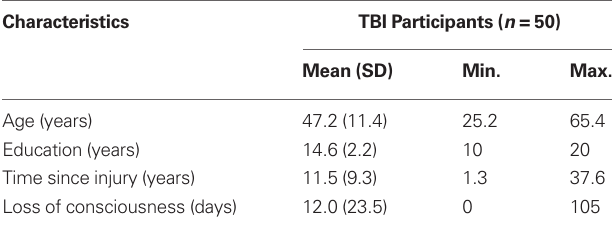
Table 1 | Demographic characterization of study